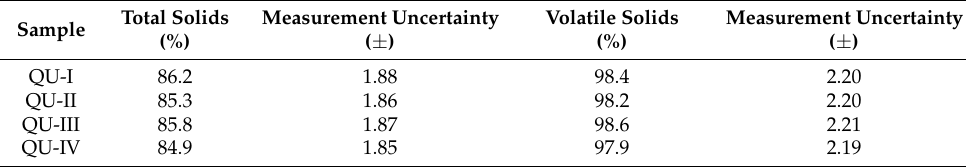
Table 4. Parameters of the analysed maize grain sampled in subsequent quarters.